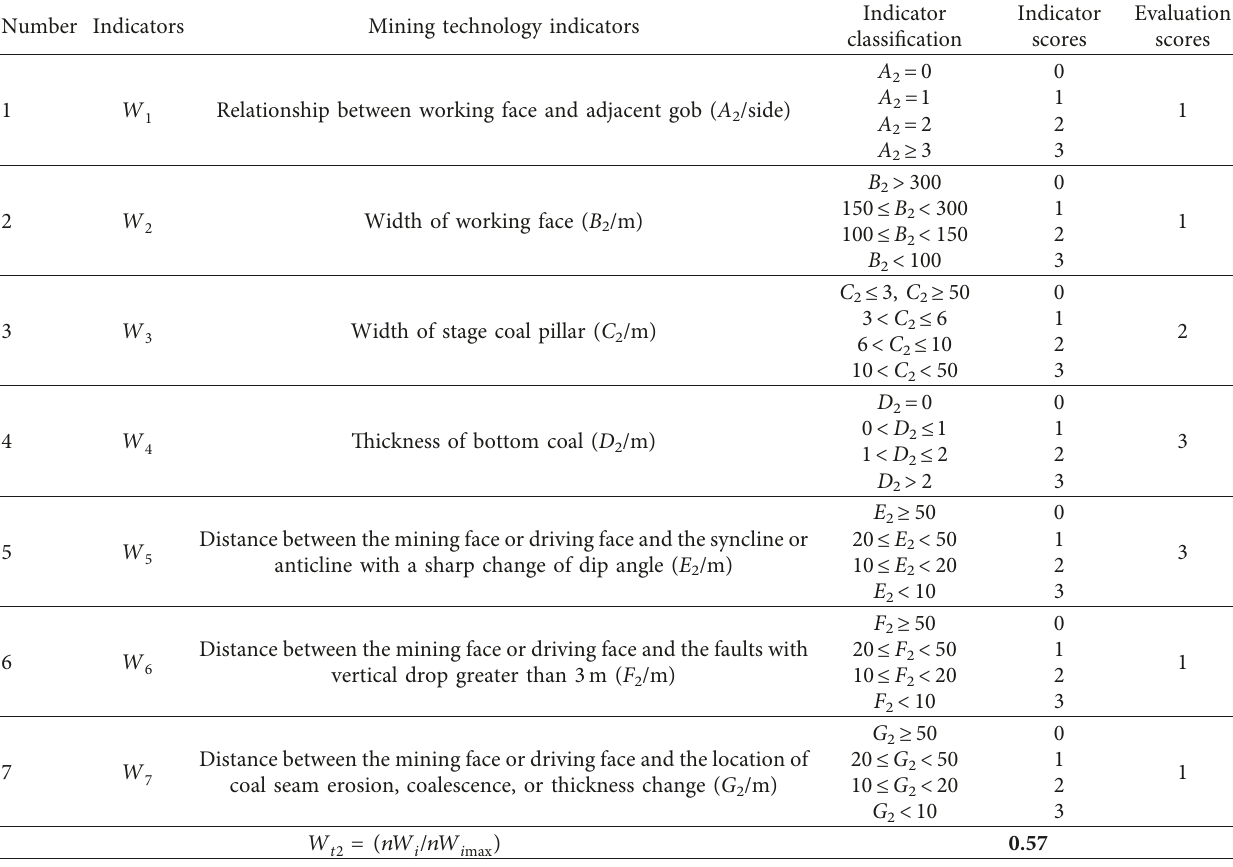
Table 2: The evaluation result of mining technology indicators.